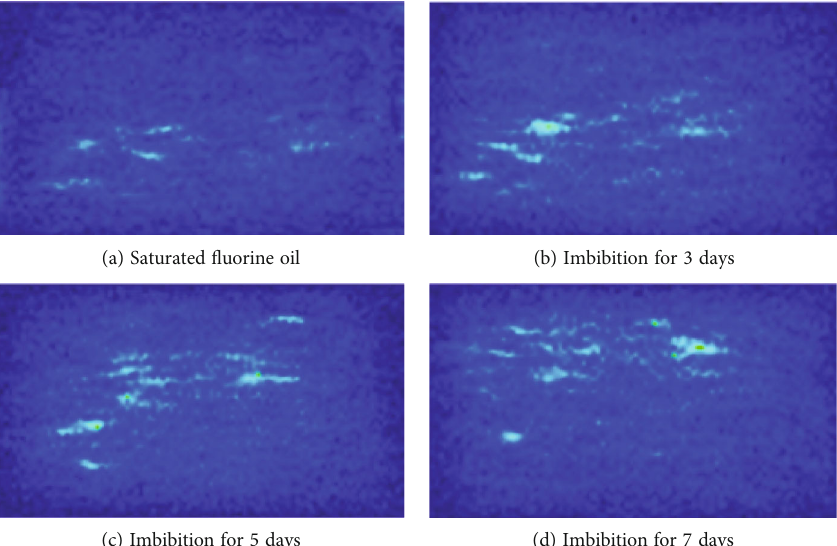
Figure 7: Pseudo-color image of core 2 (bright color is the water phase signal).